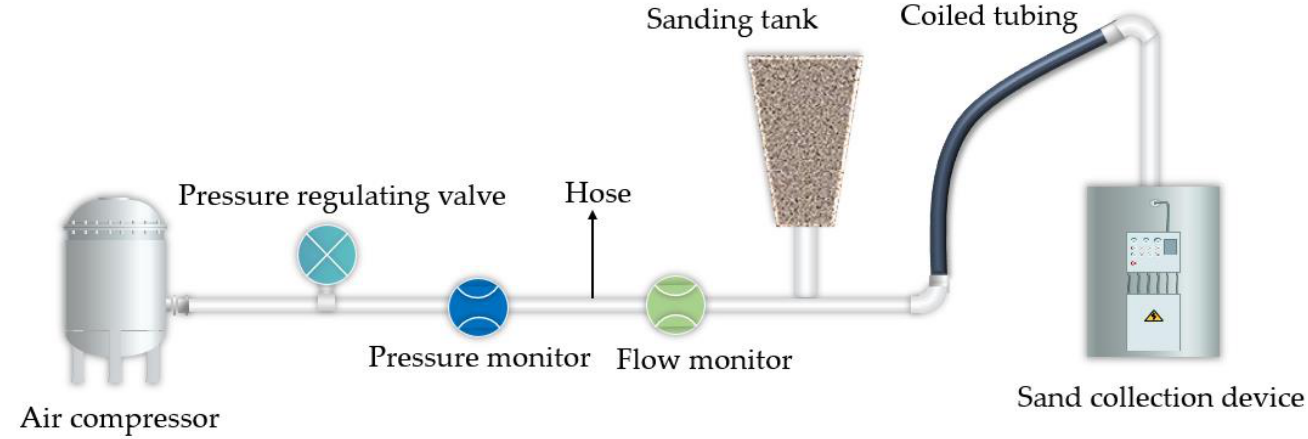
Figure 1. Schematic diagram of the full-size erosion simulator. Quartz sand was used in the experiment, which was screened with a screen before the experiment. Figure 3 shows the screen and quartz sand used for sand screening. The sand particle size is 0.25 mm. The particle mass flow rate during the experiment was 3.00 × 10 − 4